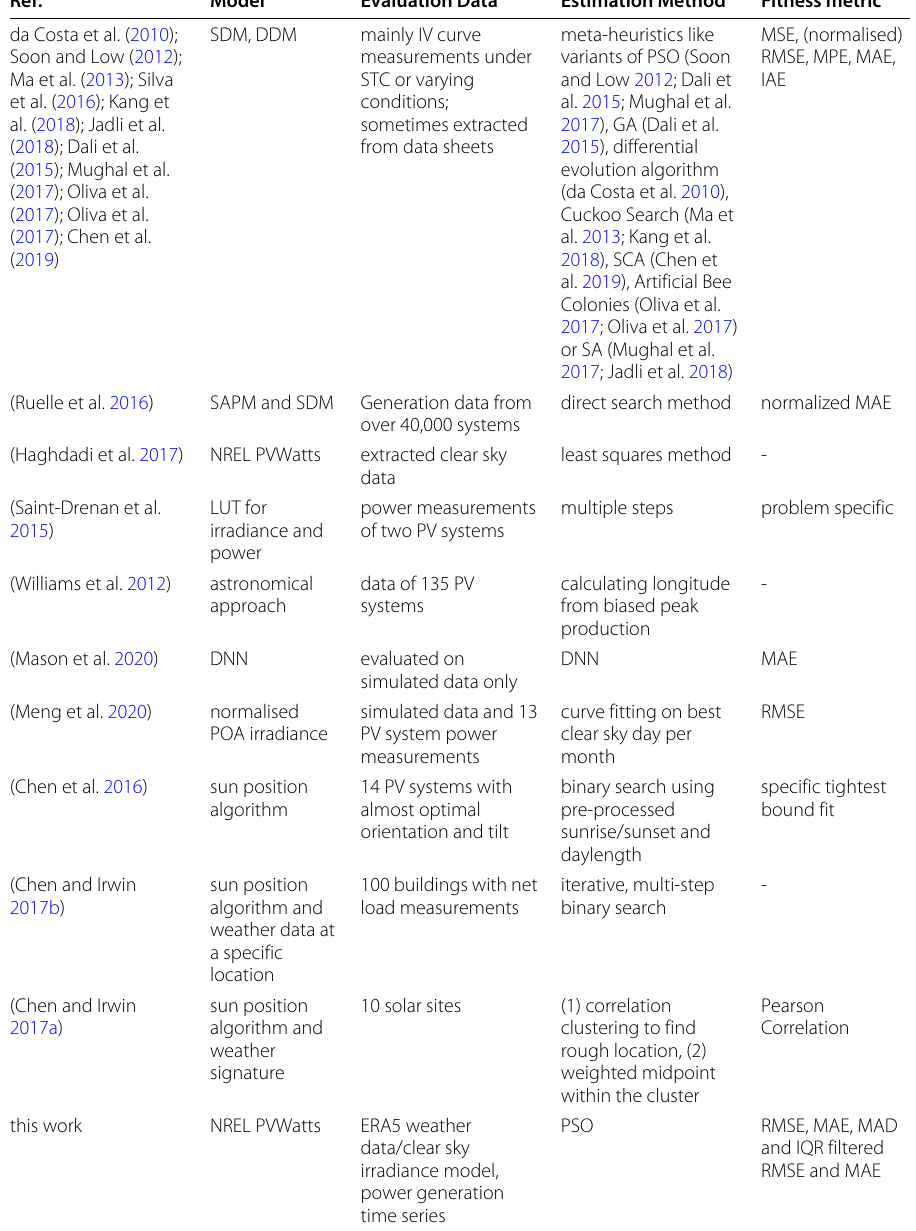
Table 1 Overview on PV parameter estimation in literature